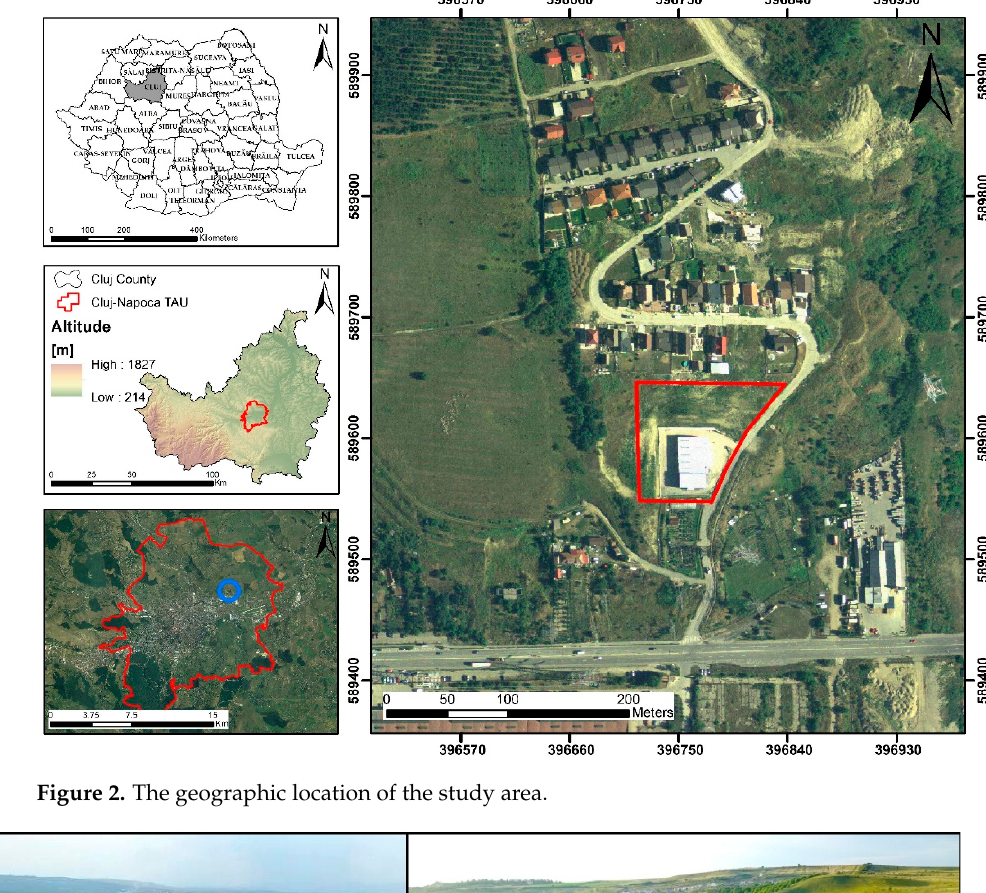
Figure 2. The geographic location of the study area.